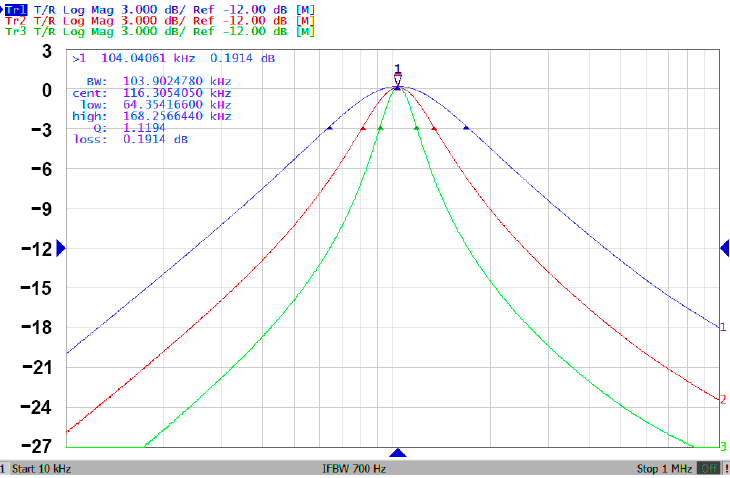
Figure 11. The experimental results of gain and phase responses of the BRF in Figure 2.